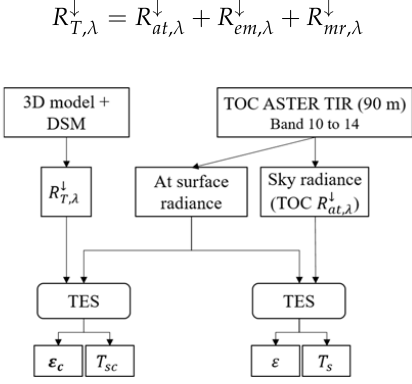
Figure 2. Processing steps to estimate corrected and non-corrected land surface temperature ( T s ) and emissivity ( (cid:2013) ) from ASTER data (TOC = top of canopy, DSM = digital surface model)